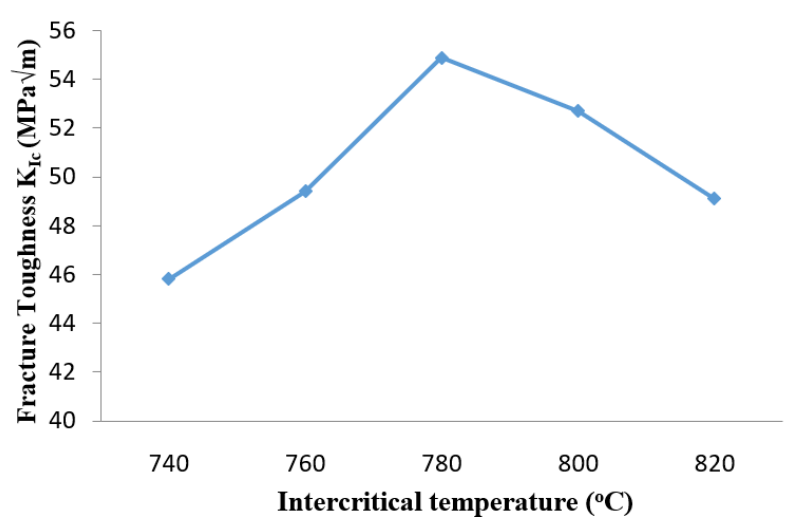
Figure 2: Variation of fracture toughness with respect to IQ